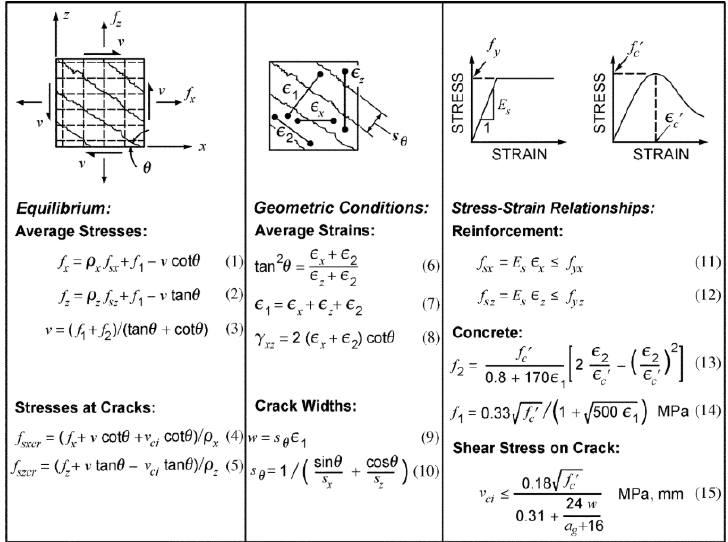
Figure 11: MCFT equilibrium, compatibility and constitutive relationships [16].